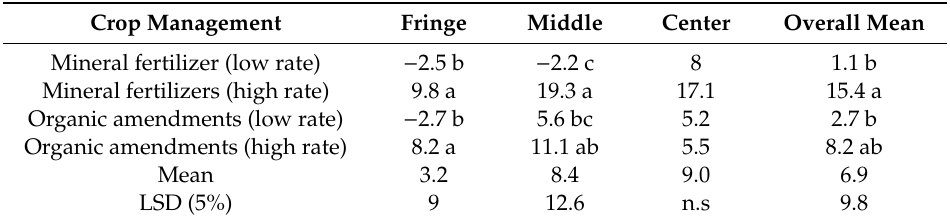
Table 3. Agronomic N-use e ffi ciency (aNUE) in kg grain per kg N for di ff erent N-management options in maize grown in Namulonge inland valley